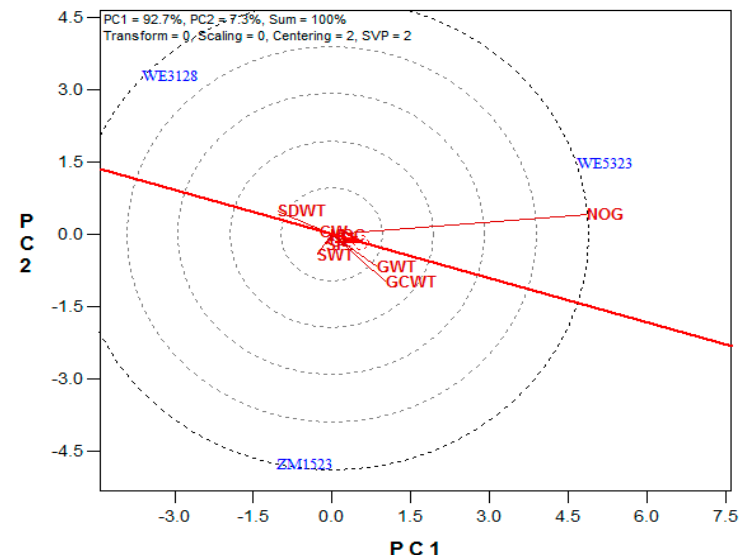
Figure 1. The mean performance vs. stability view of the three maize varieties (NOC = cob num ‐ ber, CL = cob length (cm), CW = cob width (mm), GCWT = cob weight (g plant − 1 ), GWT = grain weight (g plant − 1 ), NOG = grain number, SP = shelling percentage (%), SWT = 100 ‐ seed weight (g plant − 1 ), and SDWT = stover dry weight (g plant − 1 )).